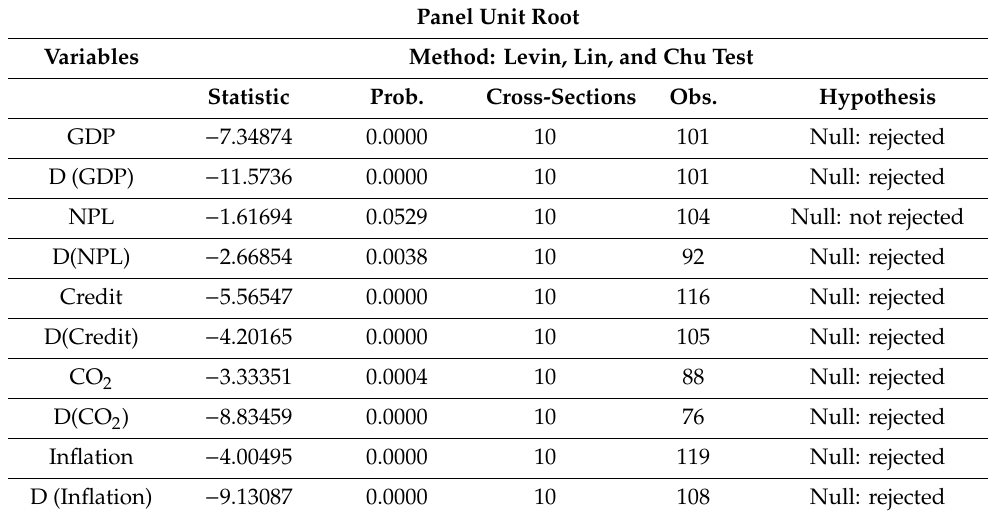
Table 4. Panel Unit Root test.